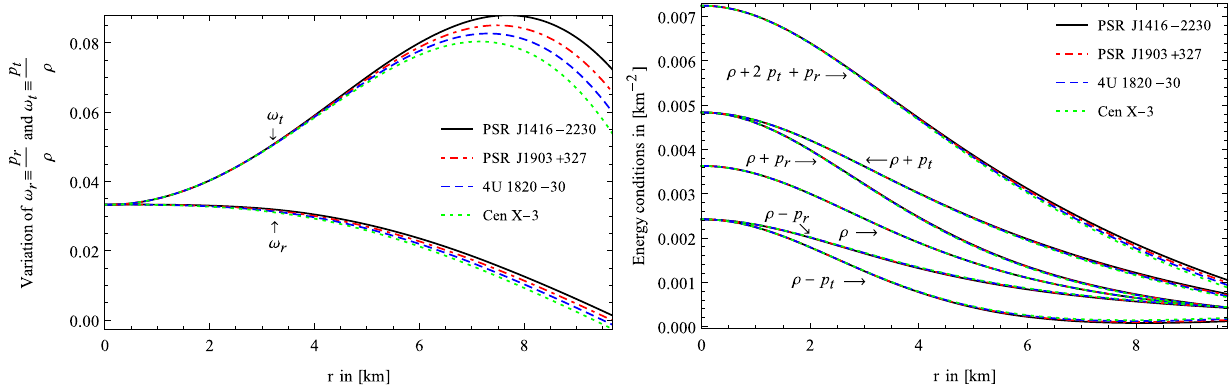
Fig. 4 The variation of equations of states viz. p r /ρ and p t /ρ (left panel) and energy conditions (right panel) with the radial coordinate r for experimental statistics of four different compact stars. For plot-